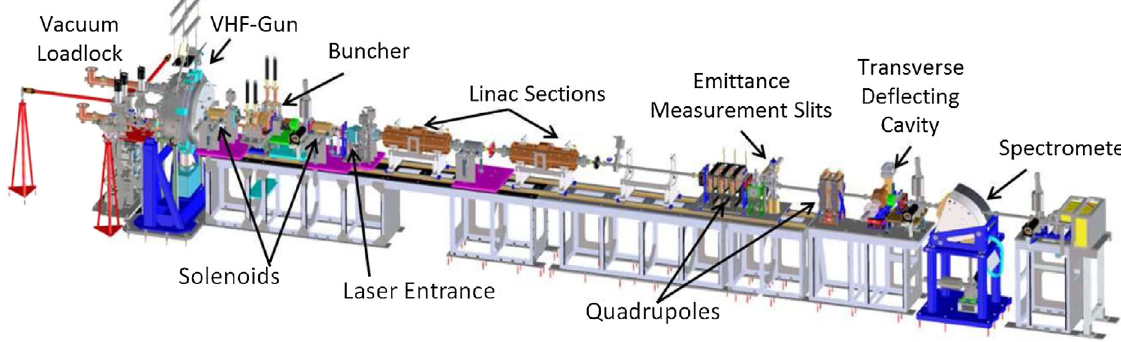
FIG. 4. APEX-like injector layout used for the beam dynamics simulations.